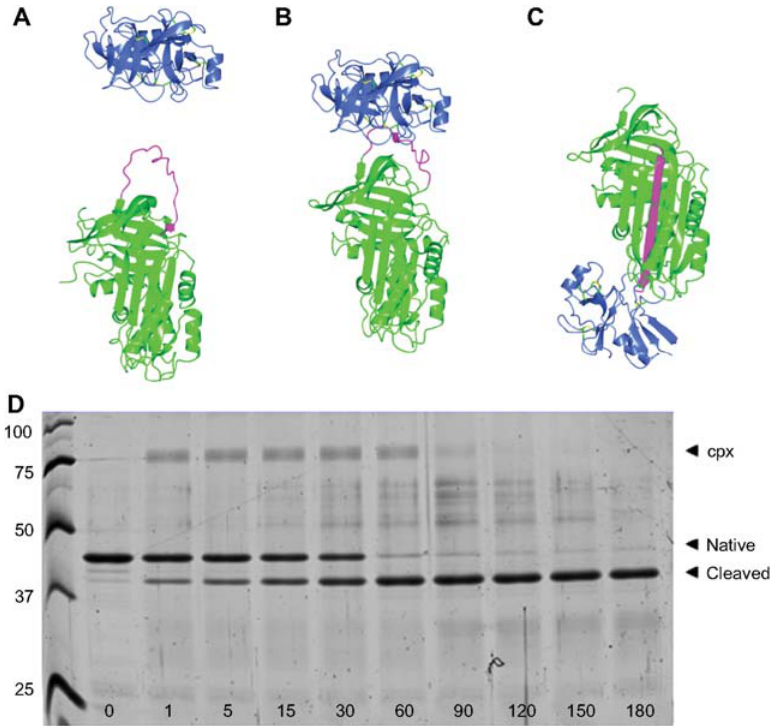
Figure 2 (A–C) Sketch representation of the three steps of serpin-protease complex formation, leading to protease inhibition. The serpin molecule is shown in green, the protease in blue; the RCL is colored magenta. (A) A serpin molecule and a serine protease are shown separately; (B) the Michaelis complex, where the RCL interacts tightly with the protease active site; and (C) once the RCL is cleaved, it is inserted in the A-sheet and the protease is dragged on the opposite side of the serpin molecule. To produce the Figure the following pdb codes were used: (i) 1OPH and 3F5N, (ii) 1OPH, and (iii) 1EZX. (D) SDS-PAGE shows the reaction between tPA and hNS over time (from 0 to 180 min): the bands corresponding to native and cleaved hNS as well as the covalent NS-tPA complex (cpx) are visible. Adapted, with permission, from Elsevier Ltd., J Mol Biol (2009; 388: 109–21), (cid:2)